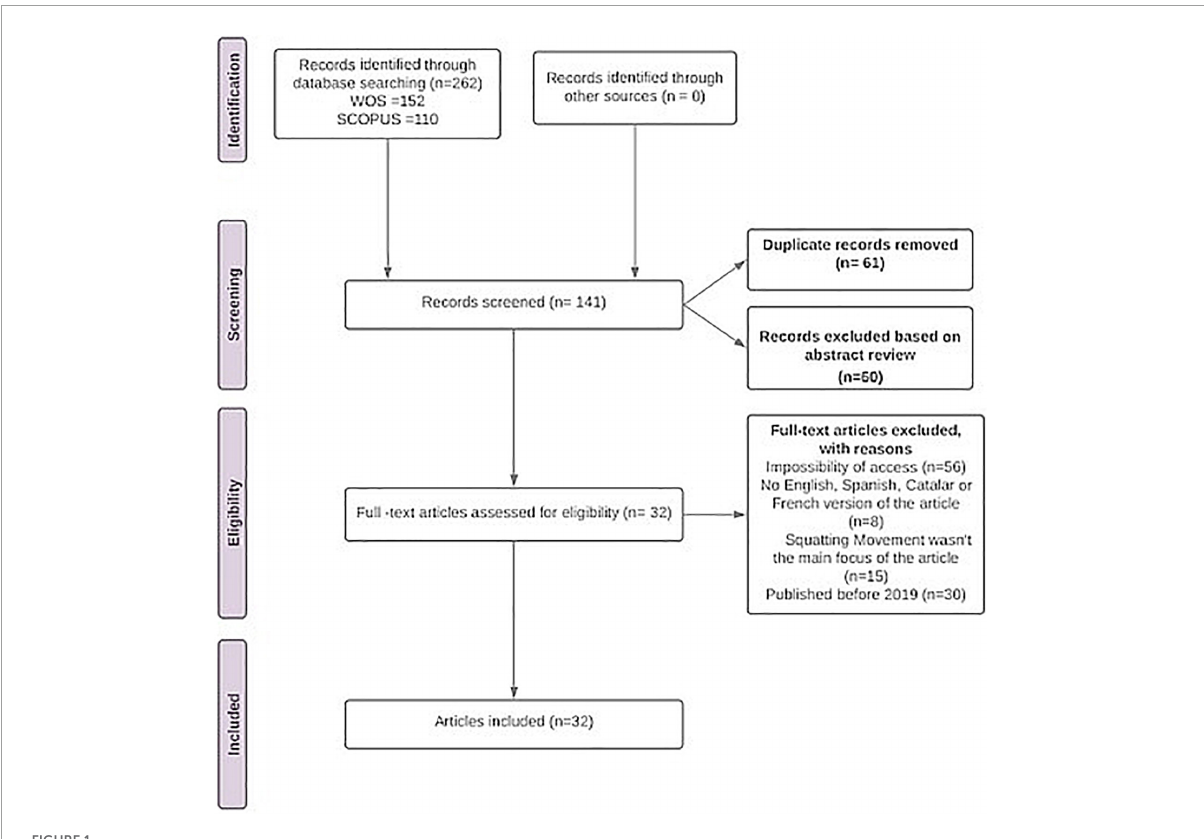
FIGURE1 Flowchart based on the PRISMA 2020 statement (Page et al., 2021). Source: own